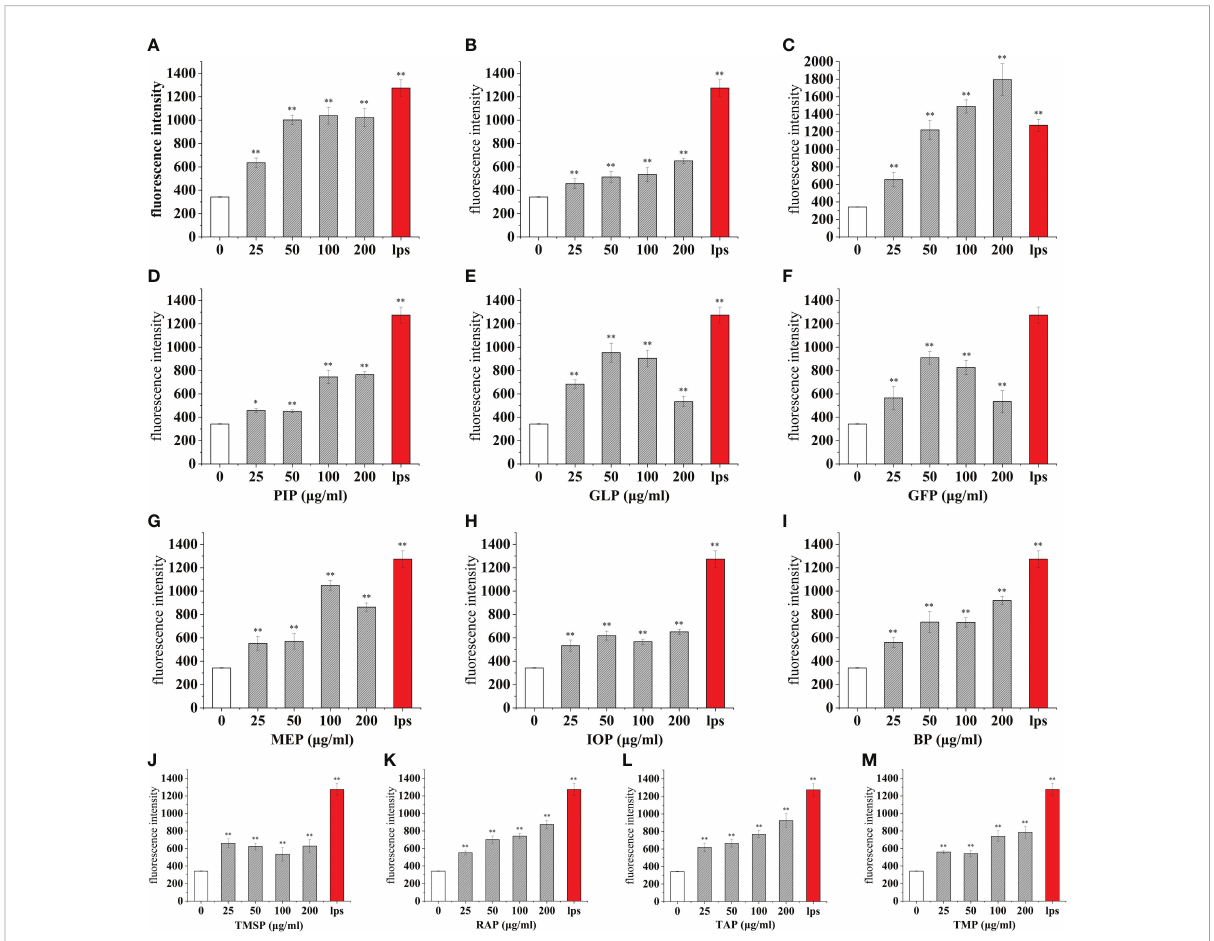
FIGURE 5 Effect of different edible mushroom protein treatments on ROS production in RAW 264.7 cells. OSP (A) , CMP (B) , CVP (C) , PIP (D) , GLP (E) , GFP (F) , MEP (G) , IOP (H) , BP (I) , TMSP (J) , RAP (K) , TAP (L) and TMP (M) on RAW 264.7 cells for ROS production. Data are expressed as mean ± SD (n = 5). *P < 0.05 and **P < 0.01 compared to the control